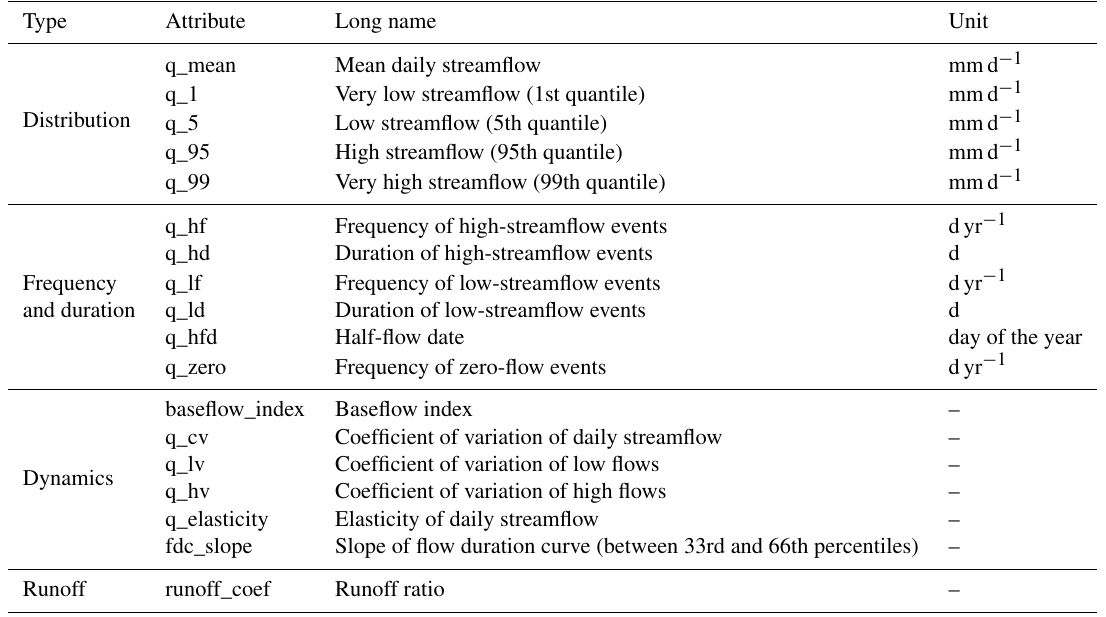
Table 4. Hydrological signatures of the CABra